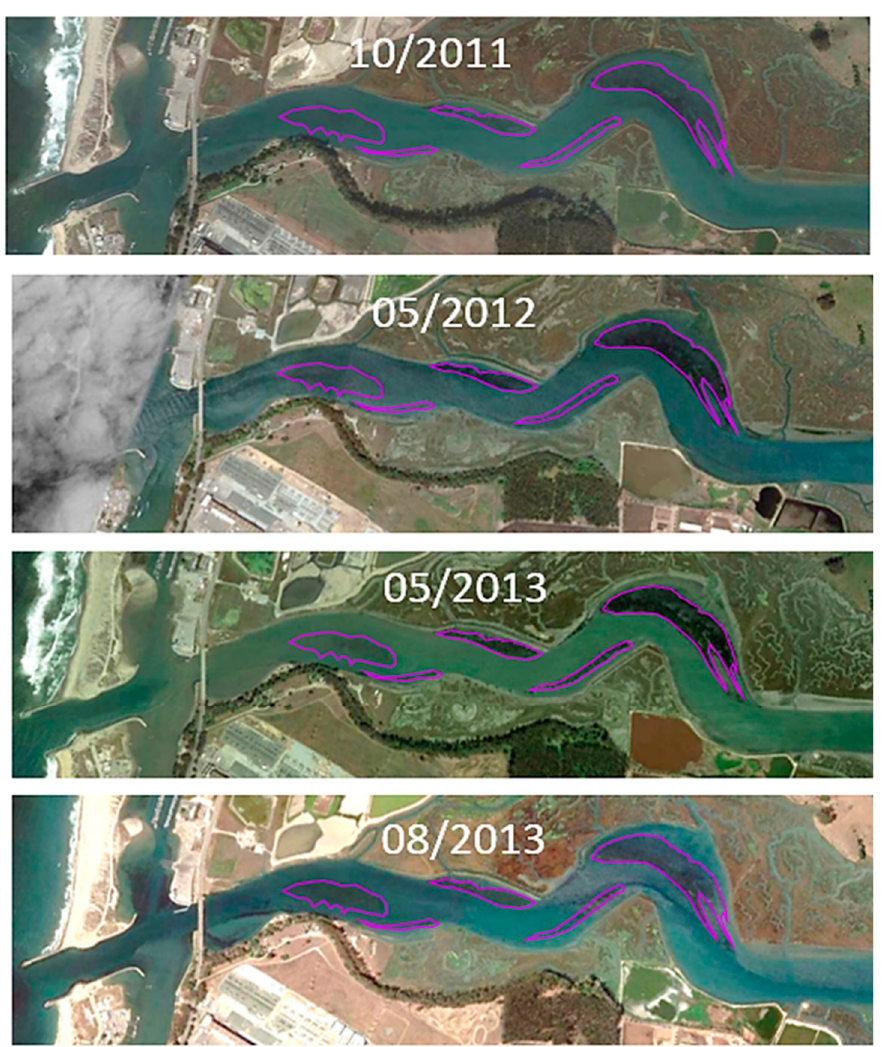
Figure 7. Comparison of available images from the Google Earth archive of Elkhorn Slough from October 2011 through August 2013. The magenta outlines provide the shapes of the five eelgrass beds revealed from the 2012 PRISM imagery.